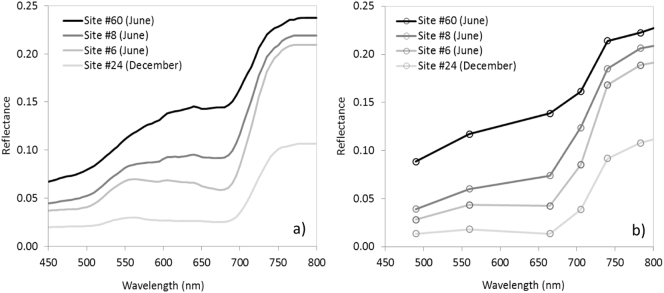
Spatially resampled hyperspectral (a) and Sentinel-2A reflectance (b) from the June and December dates and four validation sites that represented a wide range of variability (Table 4).